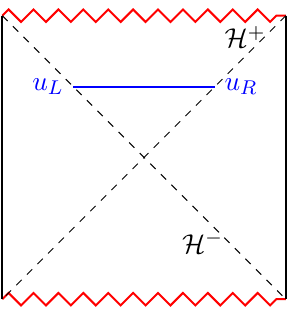
Figure 1 . Penrose diagram for a 5d single R-charged AdS black hole. The blue line represents the bridge between two equal time horizon crossing points at constant Kruskal time v 0